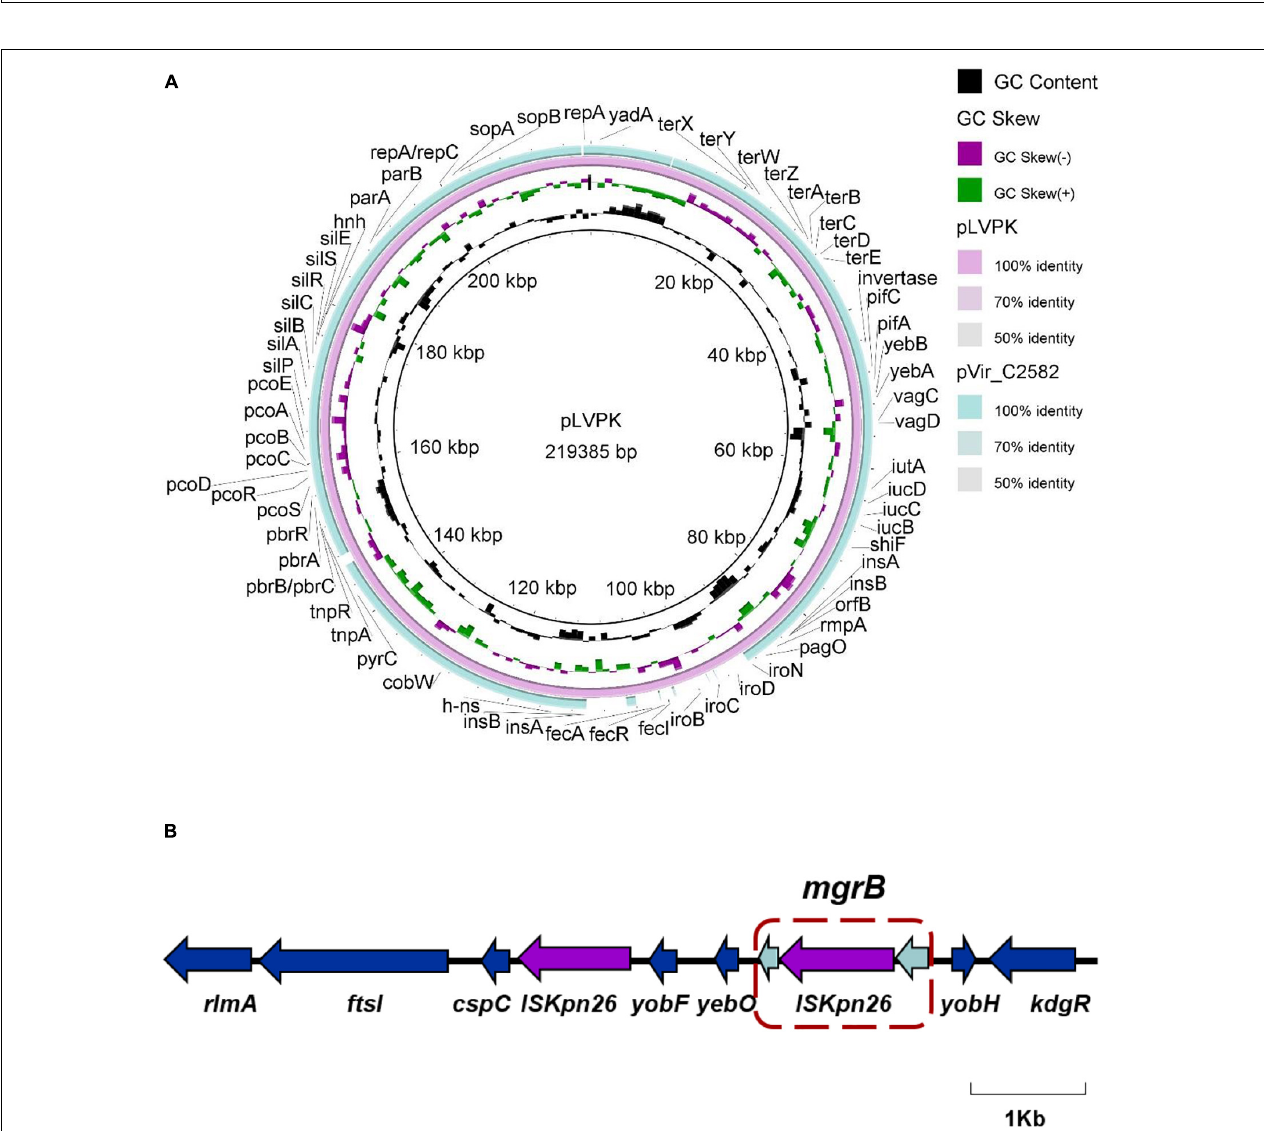
FIGURE 2 | Comparative analysis of the virulence plasmid of C2582. (A) Alignment analysis of virulence plasmid sequences between pVir_C2582 and previously reported virulence plasmid pLVPK (accession no. AY378100). (B) Schematic representation of the insertion events that occurred in the mgrB gene.